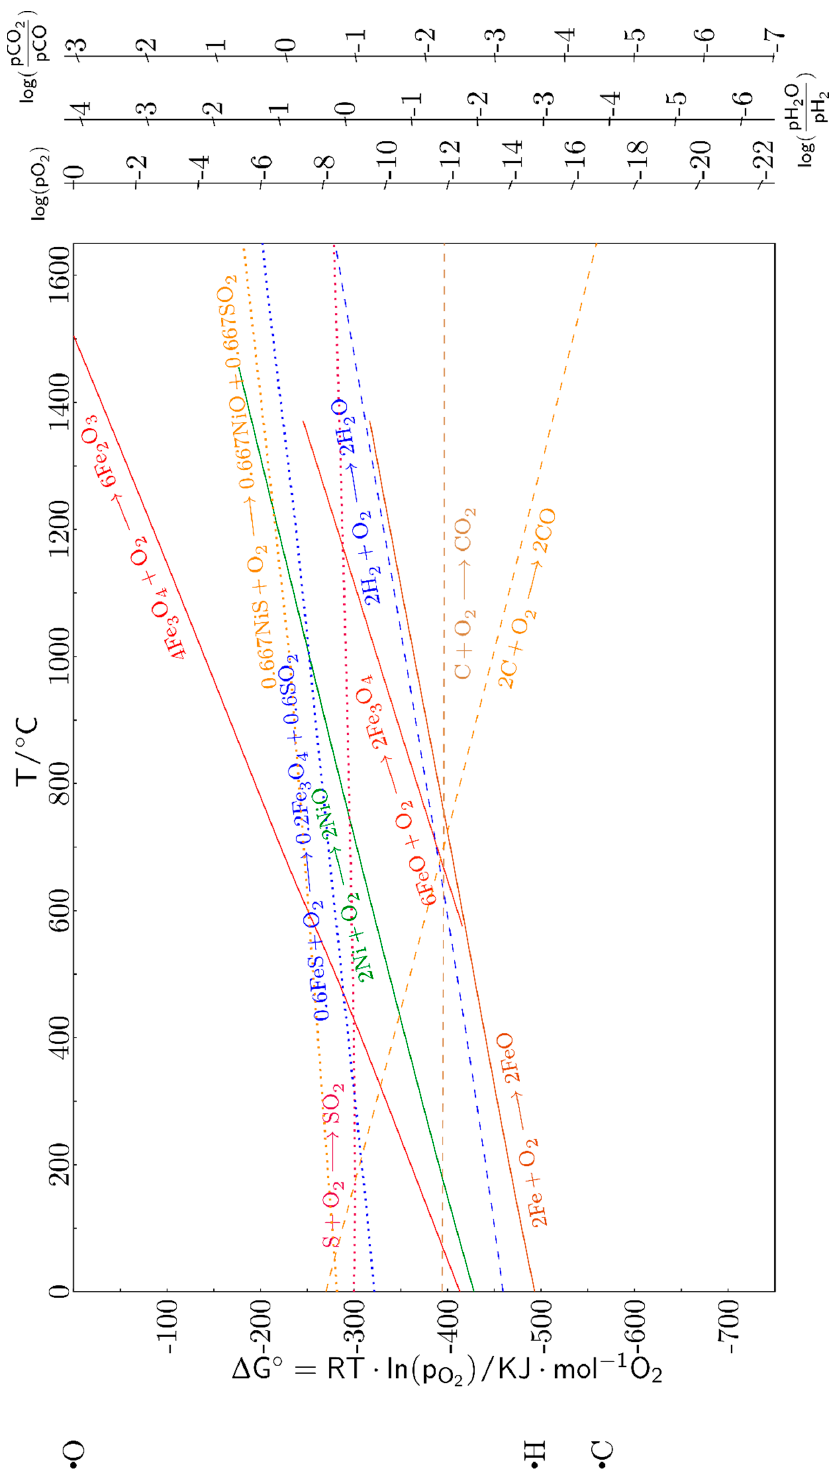
Figure 11. Ellingham diagram of selected components, calculated by FACTSAGE [142] (1 atm). Dotted lines include reactions with sulfur. Nomographic scales related to H 2 O/H 2 and CO 2 /CO with their respective origins ‘H’ and ‘C’ are included in the figure.